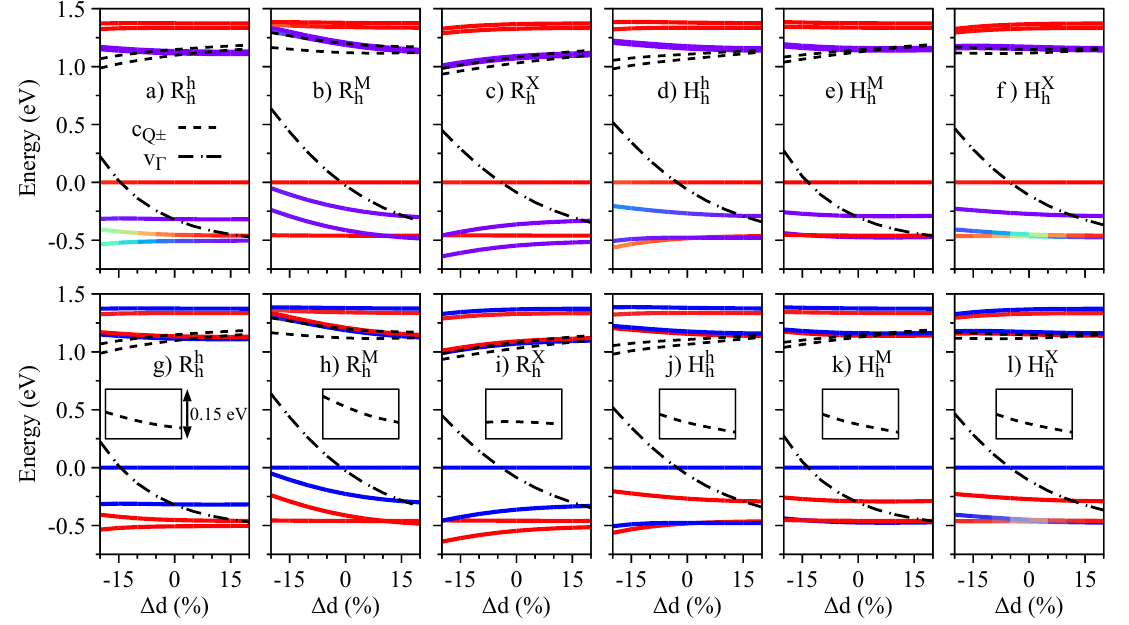
Figure 7. Same as Figure 3 but as a function of the interlayer distance variation.